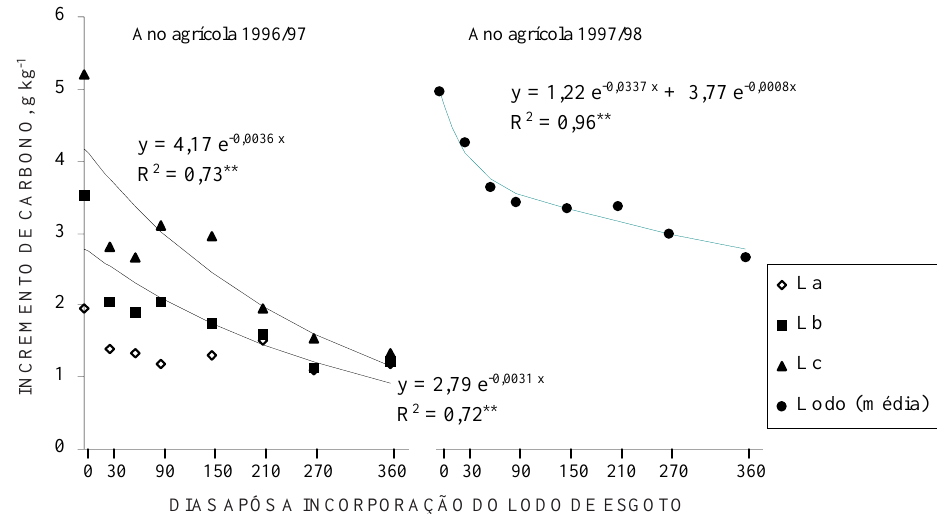
Figura 1. Decréscimo do incremento de carbono (iC) do solo em função do tempo, nos anos agrícolas de 1996/97 e 1997/98. ( ** significativo a P £££££ 0,01 pelo teste F). La = lodo dose A; Lb = lodo dose B; Lc = lodo dose C e Lodo = média de La, Lb e